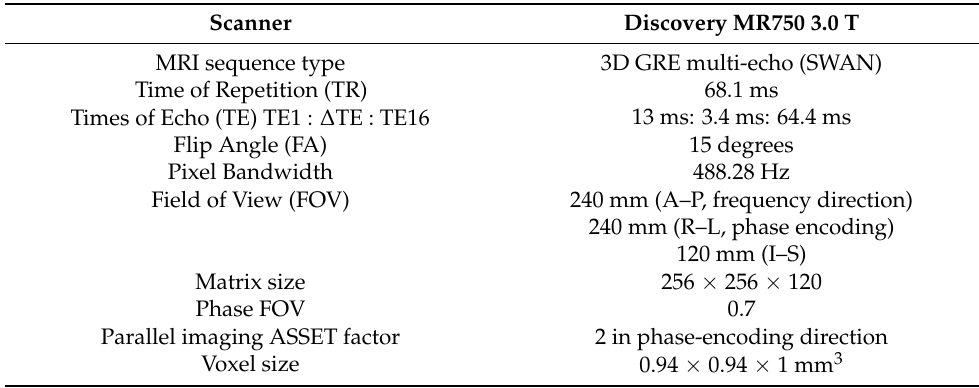
Table 1. MRI acquisition information. Abbreviations: GRE: Gradient Recalled Echo; SWAN: Susceptibility-Weighted Angiography; A–P: posterior–anterior direction; R–L: right–left direction; I–S: superior–inferior direction; ASSET: Array Coil Spatial Sensitivity